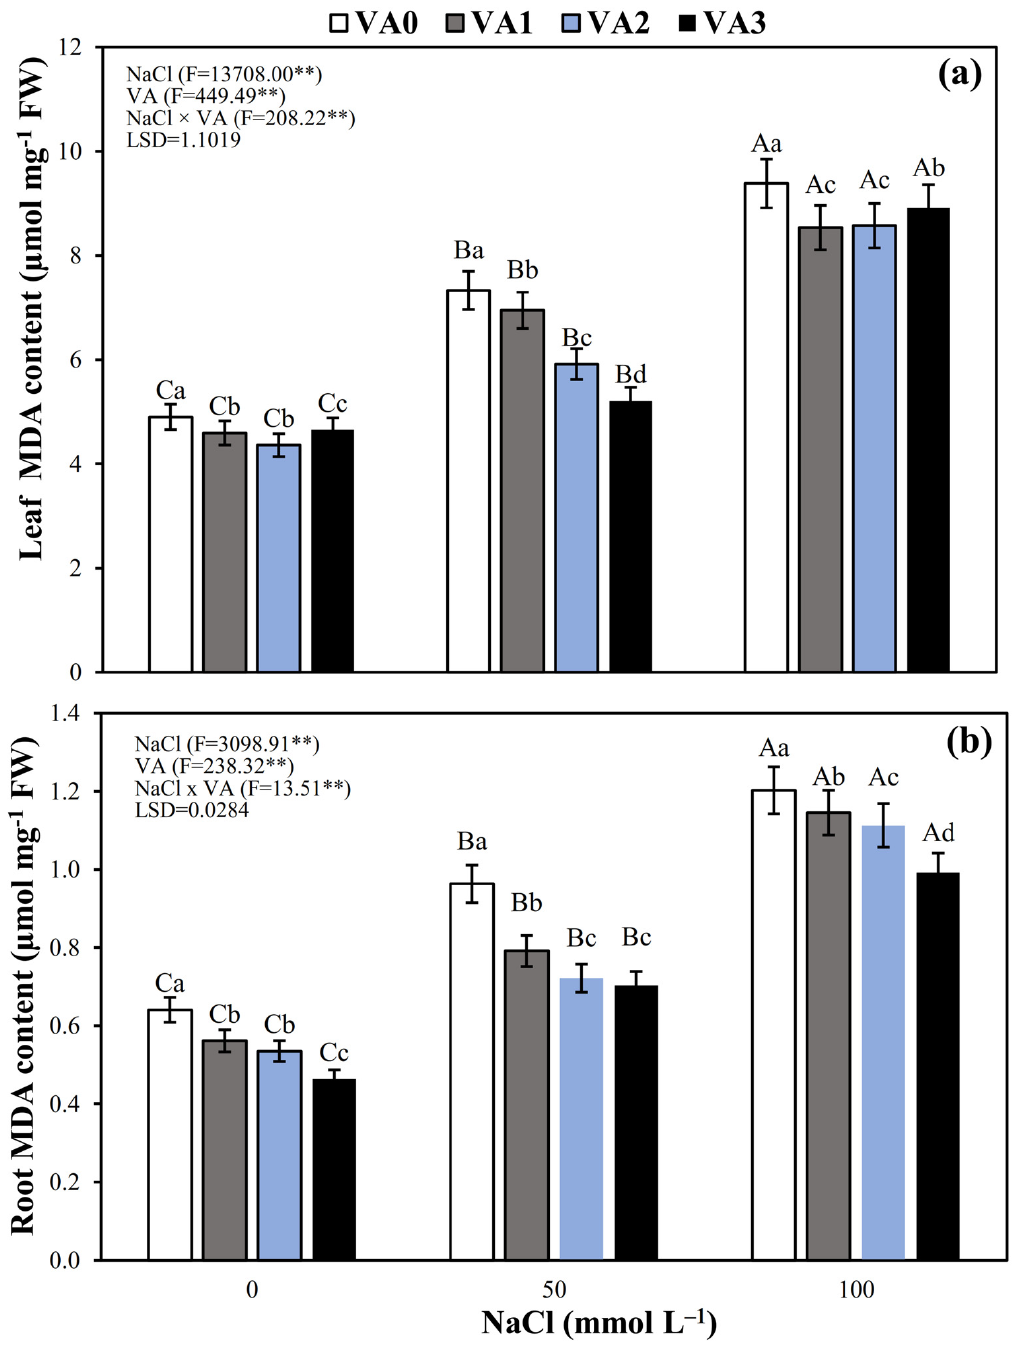
Figure 8. Leaf ( a ) and root ( b ) malondialdehyde (MDA) content of soybean plants under different levels of salt stress and VA application. Plants were submitted to four concentrations of VA (VA0, non-VA application; VA1, 0.4 mL L − 1 ; VA2, 0.8 mL L − 1 ; and VA3, 1.2 mL L − 1 ) and three levels of NaCl (0, 50, and 100 mmol L − 1 ). Data are mean ± SD (n = 5). Uppercase letters above bars indicate significant differences among NaCl concentrations at the same VA concentration. Lowercase letters above bars indicate differences among VA concentrations at the same NaCl concentration, according to LSD test ( p < 0.05). F values from ANOVA: ** p < 0.01.